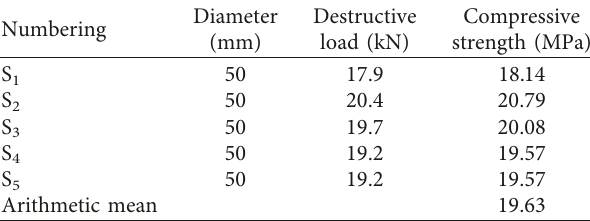
Table 3: Compressive strength after water